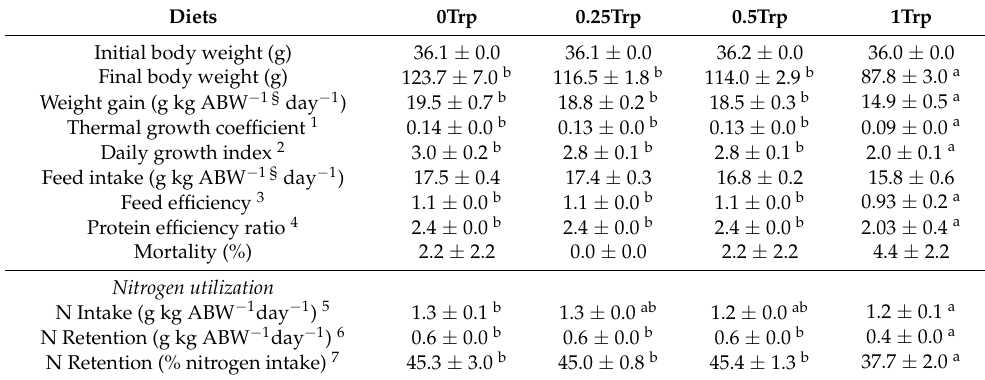
Table 3. Growth performance and feed utilization efficiency of meagre fed the experimental diets.